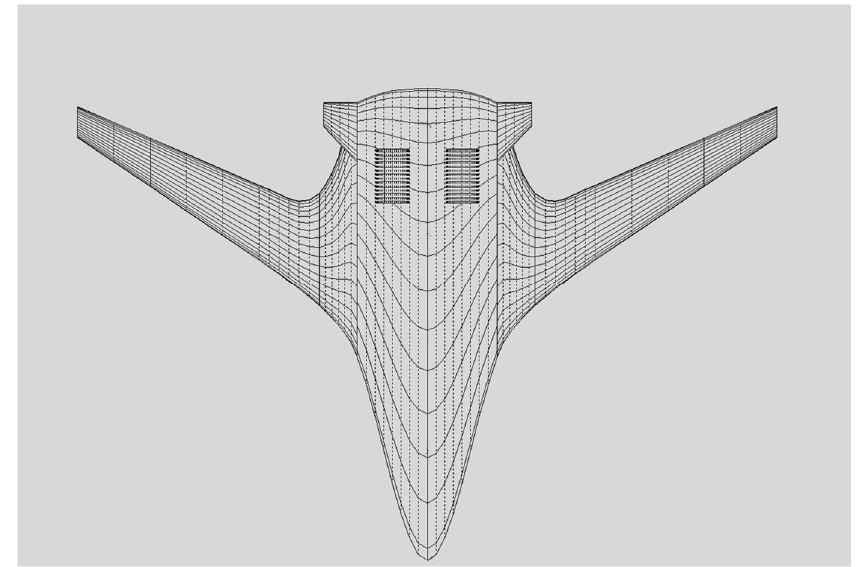
Figure 5. AVL mesh model of the HWB aircraft.